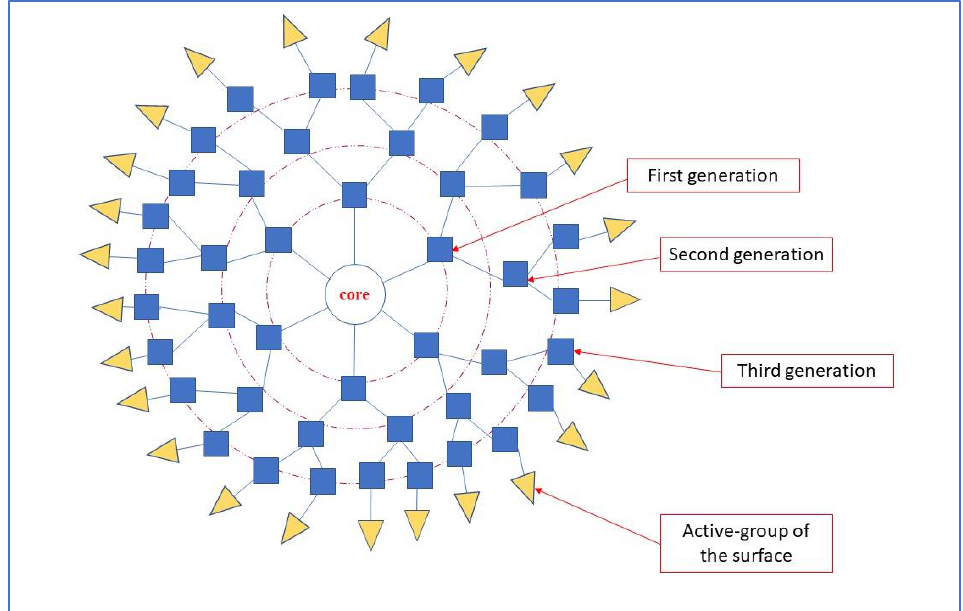
Figure 1. A graphic representation of a dendrimer. In red boxes the denomination of each component of the dendrimeric structure. As indicated, a central core and the radially-disposed dendrons, from the interior branches (first generation) to the external branches (third generation). The branch points divide the dendrons into generations. In the more external region, in yellow triangles, the functional groups.